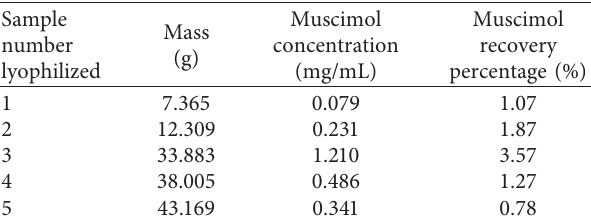
Figure 3: Calibration curve of muscimol. Figure 4: Muscimol chromatogram from Amanita muscaria samples also featuring the standard sample of MUS. Table 1: MUS concentration in samples of the developmental stages of the